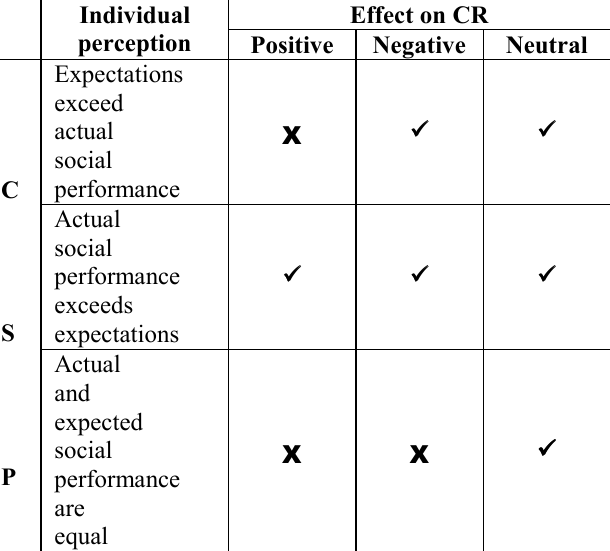
Table 1: The effects of expected and actual CSP on CR